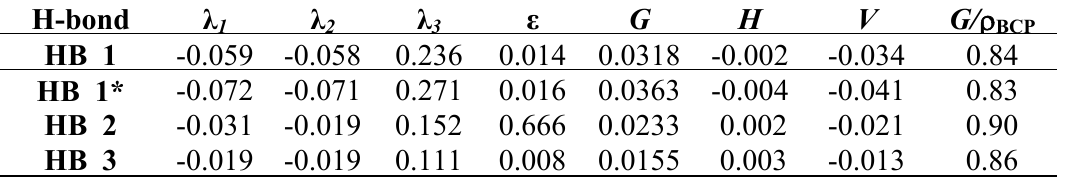
, of hessian of electron density; ellipticity, ε ; kinetic energy Table 5. Eigenvalues, λ i density, G ; potential energy density (or virial field), V ; total energy density, H ; and ratio ; computed at the corresponding BCPs for between G and electron density at BCP, ρ BCP each hydrogen bonding, according to the AIM analysis of flavonoid V (luteolin) and XIII (quercetin) in gas phase at the B3LYP/6-311++G** theoretical